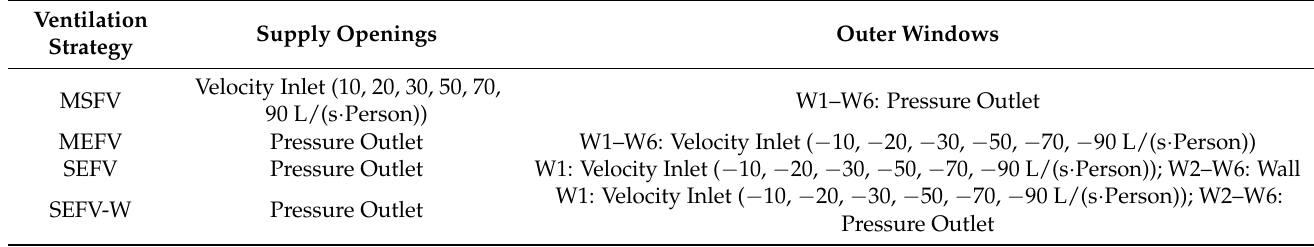
Table 1. The detailed settings of the air supply openings and outer windows under different ventila- tion strategies.